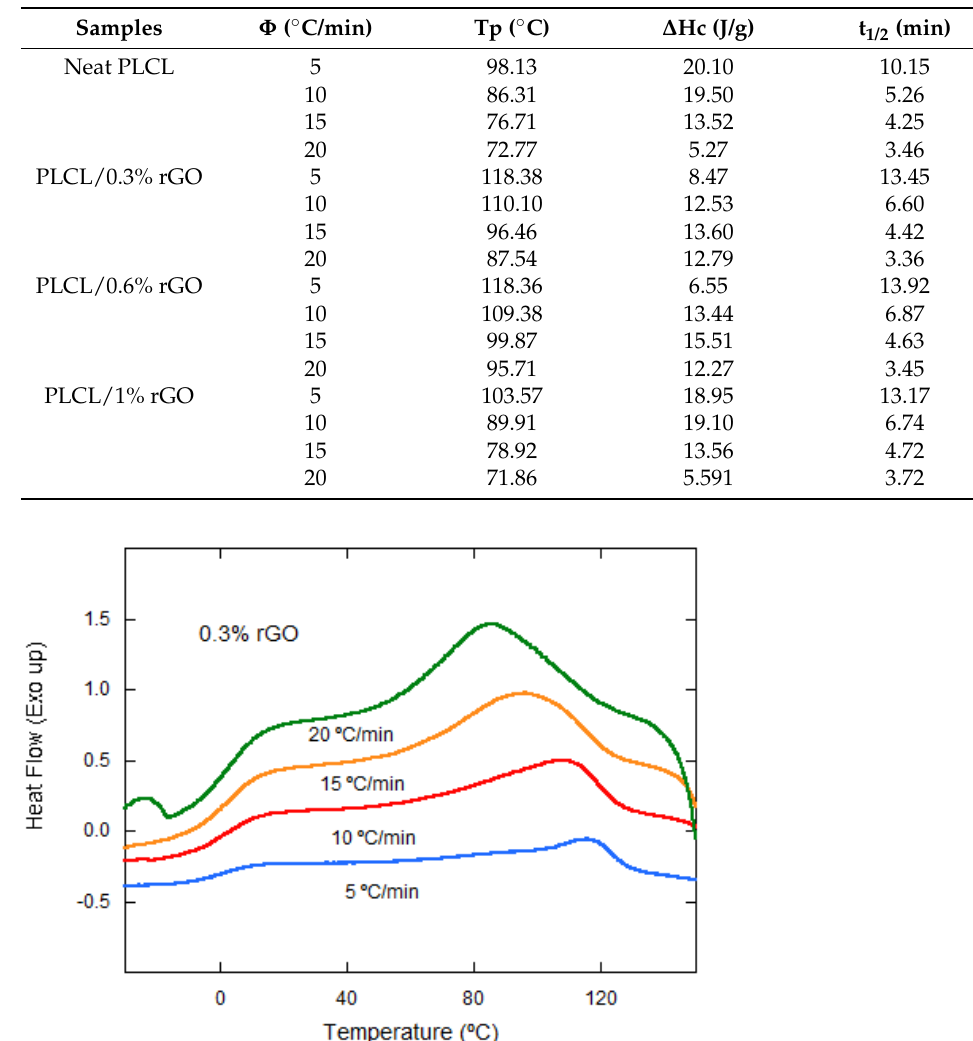
Table 2. Summary of relevant thermal parameters for neat PLCL and its nanocomposites: cooling rate ( Φ ), nonisothermal peak temperature (Tp), crystallization enthalpy ( ∆ Hc), and nonisothermal crystallization half-time (t 1/2 ).